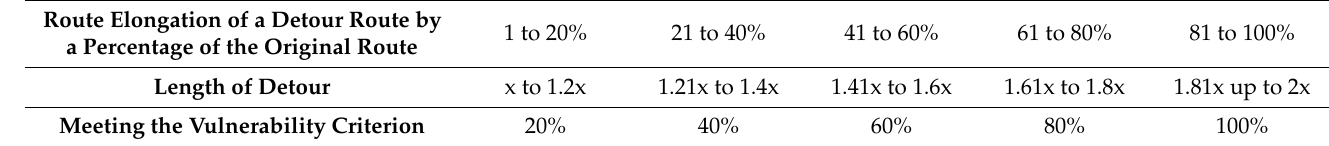
Table 2. Length of Detour.